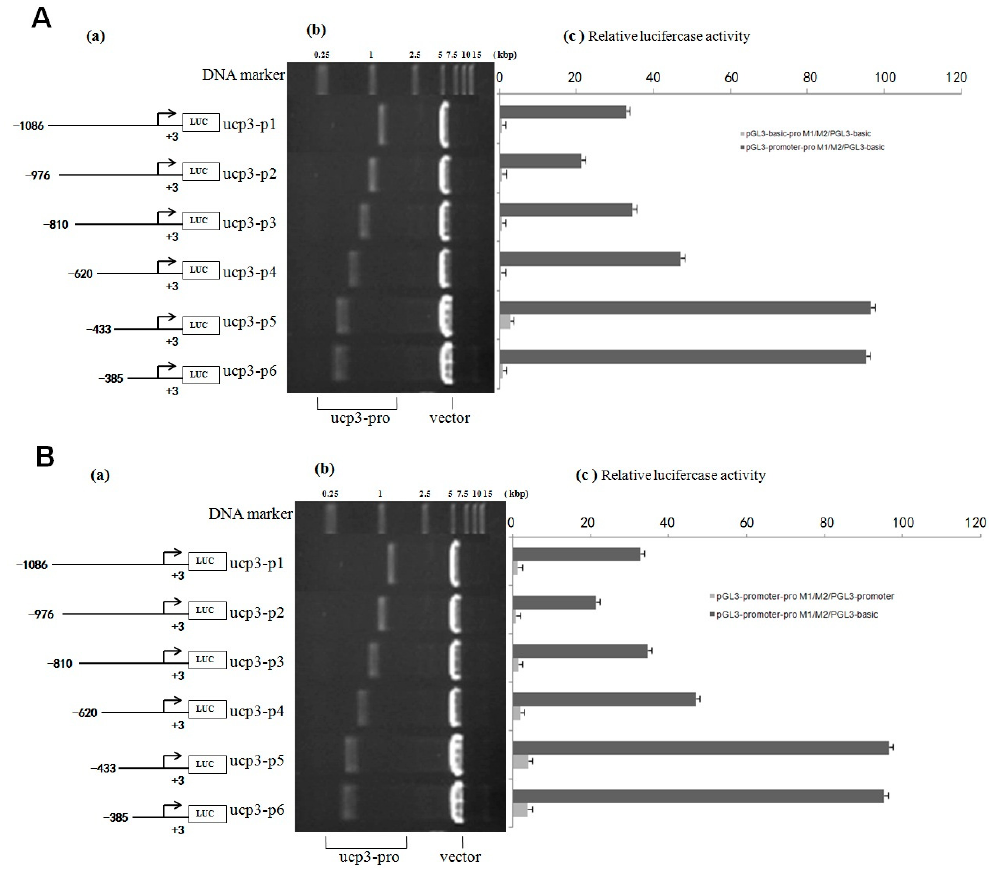
Figure 5. Analysis of the cattle UCP3 promoter. ( A ) Analysis of activity of pGL3-basic-ucp3-pro/pGL3-basic and pGL3-promoter-ucp3-pro/pGL3-basic; ( B ) Analysis of activity of of pGL3-promoter-ucp3-pro/pGL3-basic and pGL3-promoter-ucp3-pro/pGL3-promoter. ( a ) Schematic diagram of the ucp3 promoter constructs consisting of the 5 ′ -flanking region with serial deletions cloned into the pGL3-basic and pGL3-promoter vector. The arrows show the direction of transcription. The numbers represent the end points of each construct; ( b ) The deletion plasmids were digested by the restriction enzyme and run on a 1.5% agarose gel. The size of vector is 4.8 kb. The inserted fragments of the ucp3 promoter range from 389 to 1086 bp which are confirmed by sequencing; ( c ) The deletion plasmids were cotransfected with pGL3-basic and pGL3-promoter into C2C12 cells; the cells were harvested 24 h later after transfection and luciferase activity was measured and expressed in relative luciferase units (RLU).